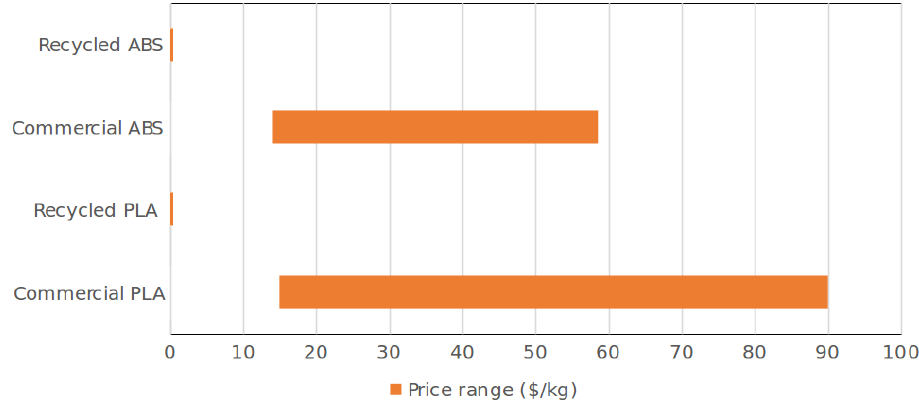
Figure 2. The general cost ranges for the recycled filament and commercial filament.